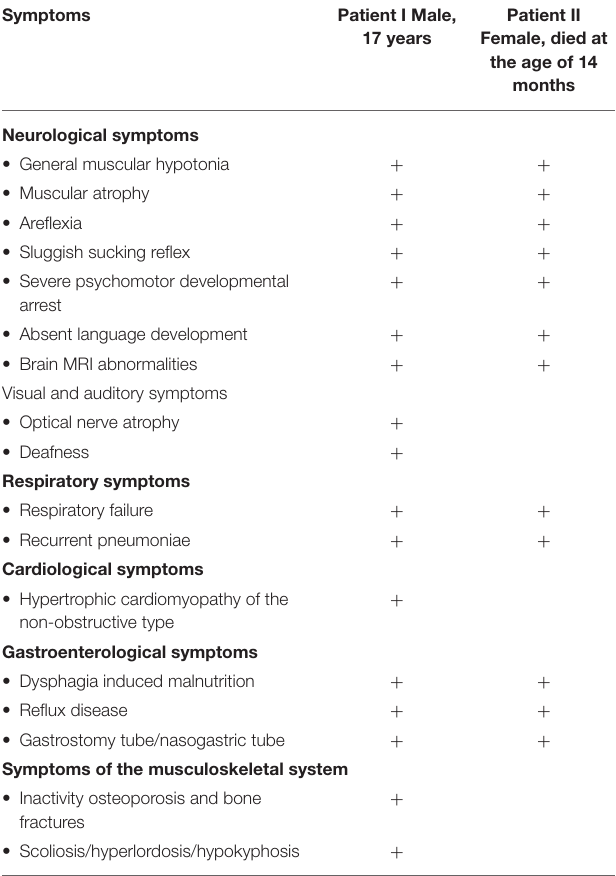
Patient II 17 years Female, died at the age of 14 months